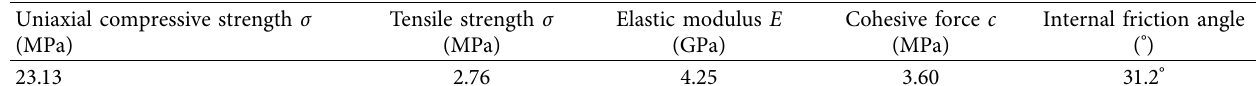
Figure 2: Failure modes of rock specimens with two fissures under biaxial loading. (a) Shear failure (b) Tension-shear mixed failure (c) Wing crack propagation failure. Table 1: Physical properties of experimental specimens.